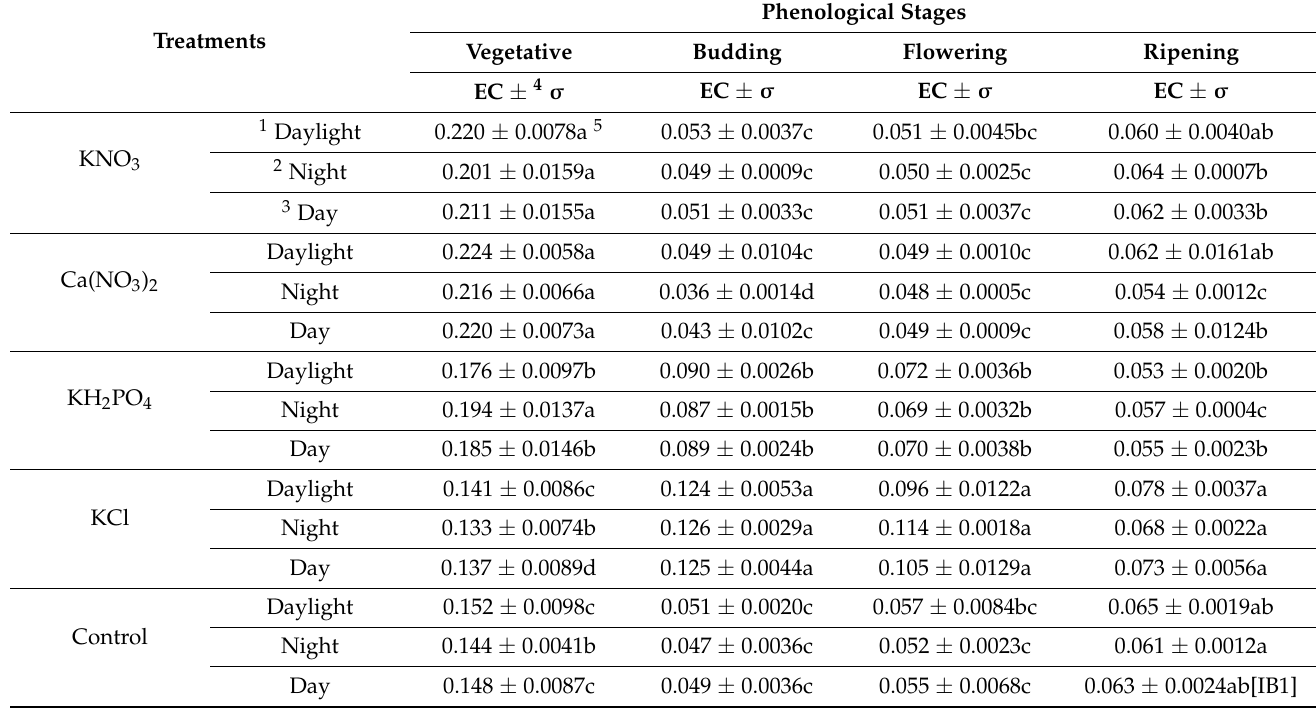
Table 1. The average of electrical conductivity of tomato plants determined in different phenological stages (dS · m − 1 ). Phenological Stages Treatments Vegetative Budding Flowering Ripening EC ± 4 σ EC ±